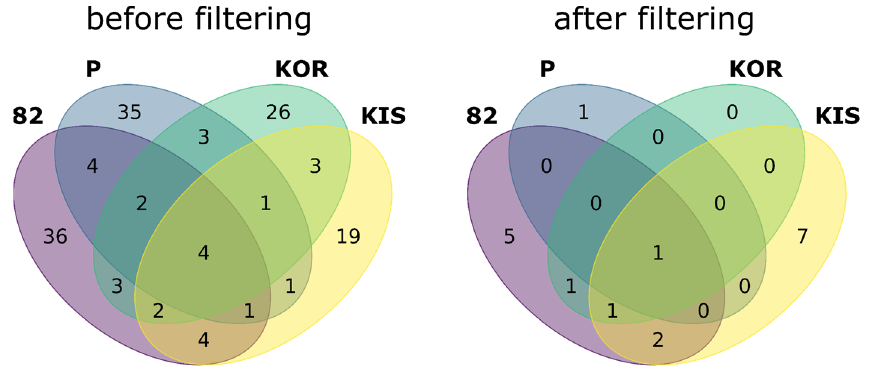
Figure 3. Numbers of novel AS events were identified at the protein level using the CombiDB before and after three-step filtering.